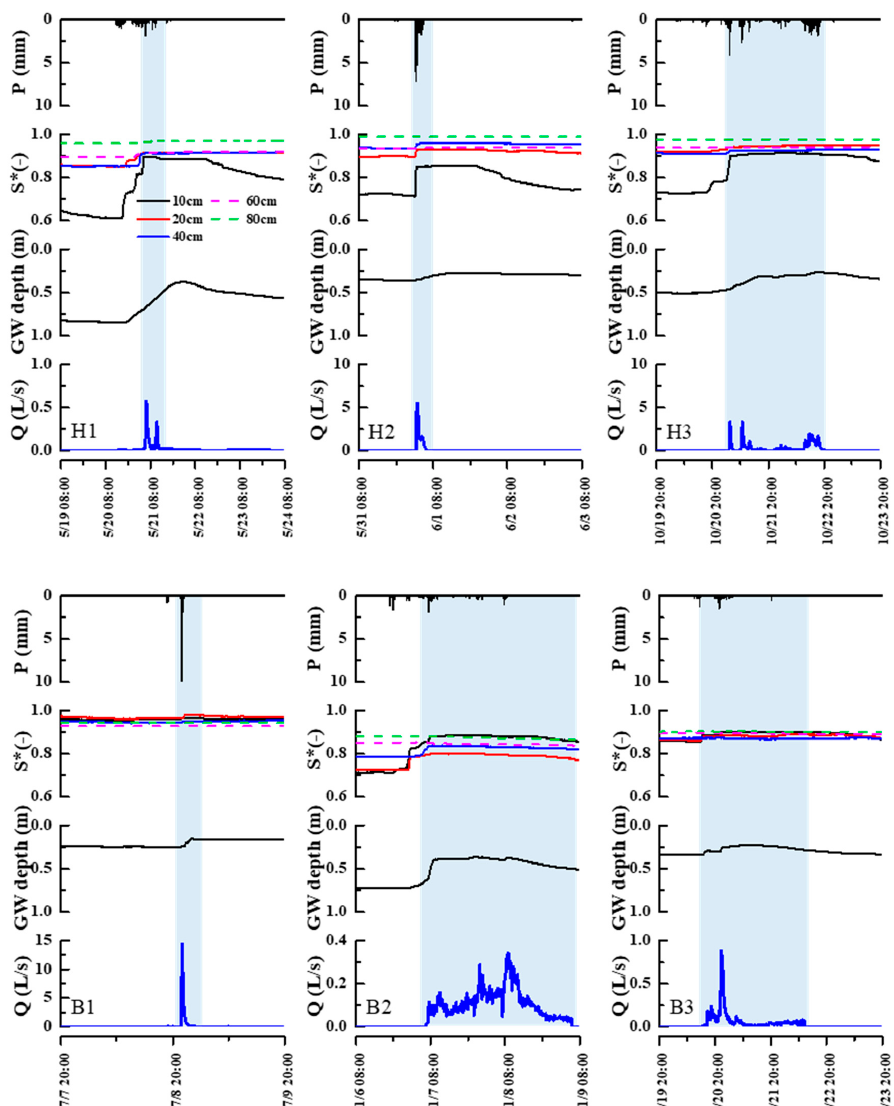
Figure 4. Time series of rainfall ( P ), relative saturation at 10, 20, 40, 60, and 80 cm below the soil surface ( S* ), groundwater depth (GW depth), and discharge ( Q ) at the outlet for events H1–H3 in the HQW site and B1–B3 in the BTQ site with a time interval of 10 min. Table 3. Summary of rainfall and runoff characteristics for the six selected rainfall events.